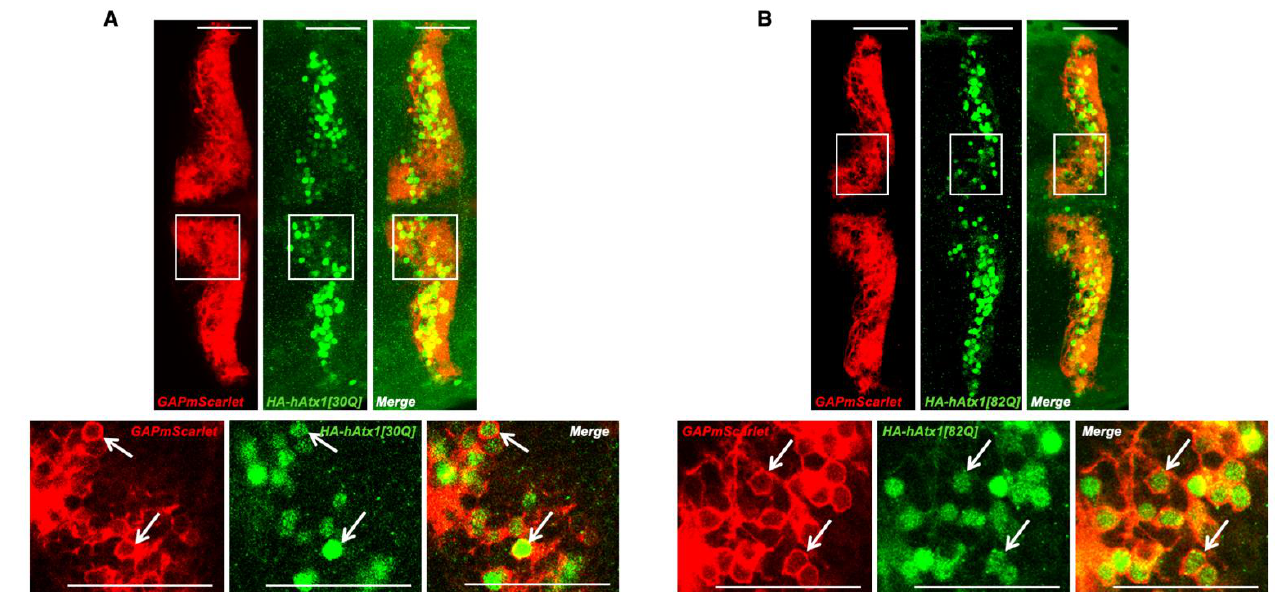
Figure 2. Analysis of human Atx1 allele expression in the stable transgenic zebrafish strains. Anti-HA immunostaining of HA-tagged proteins hAtx1[30Q] ( A ) and hAtx1[82Q] ( B ) in transgenic 4 dpf F2 larvae of established Atx1[30Q] and Atx1[82Q] strains crossed into the transgenic Tg(-7.5ca8:GFP) bz12 backgroundCytoplasmic and nuclear anti-HA-derived green fluorescence is surrounded by PC-specific membrane targeted red fluorescent GAPmScarlet expression (white arrows) The images display a dorsal view of the larval zebrafish corpus cerebelli, anterior is to the left. While in the upper row an overview over both cerebellar hemispheres is shown, the white boxes depict an area that was displayed at higher magnification in the lower row. Scale bars: 50 µm.